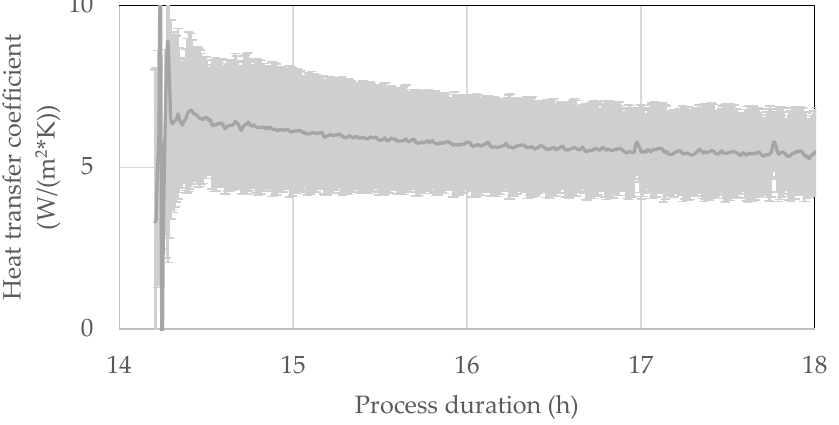
Figure 17. Vial heat transfer coefficient during primary drying duration measured with heat flux sensor (T_s= −25 °C, p _c= 0.15 mbar).